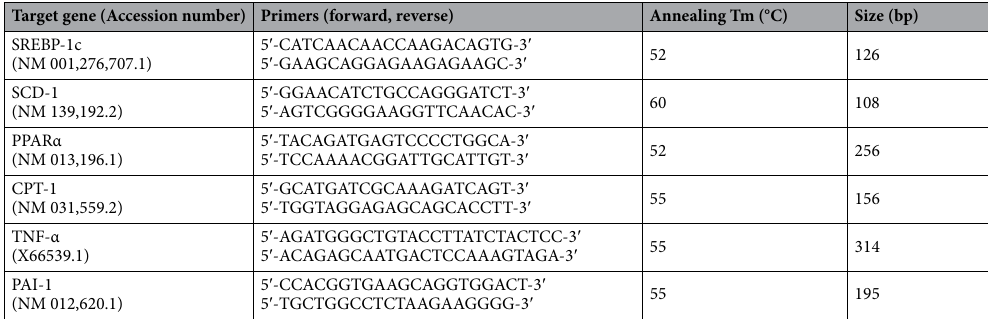
Target gene (Accession number) Primers (forward,